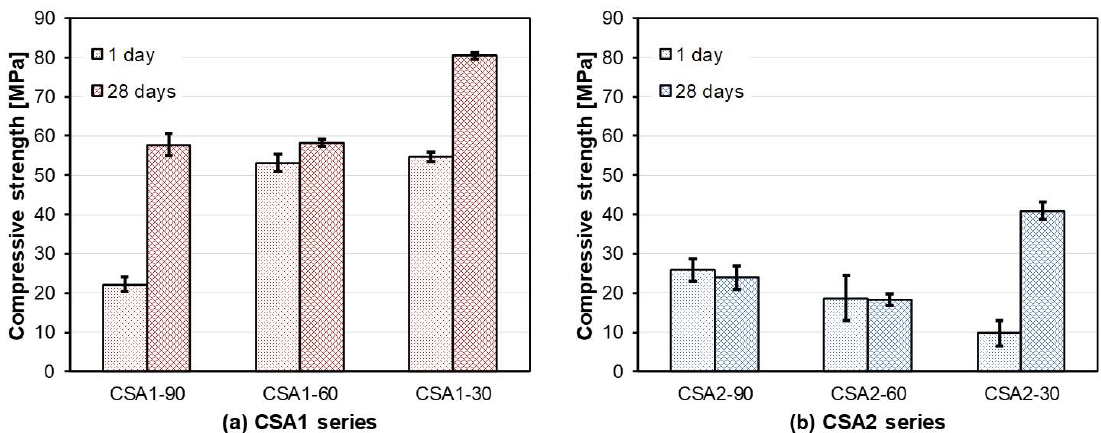
Figure 3. Development of compressive strength of ( a ) CSA1 and ( b ) CSA2 cement based mortars up to 28 days. Error bars of each measurement points indicate obtained standard deviations from three replicates. Specific values including its standard deviation are represented in Table S1.